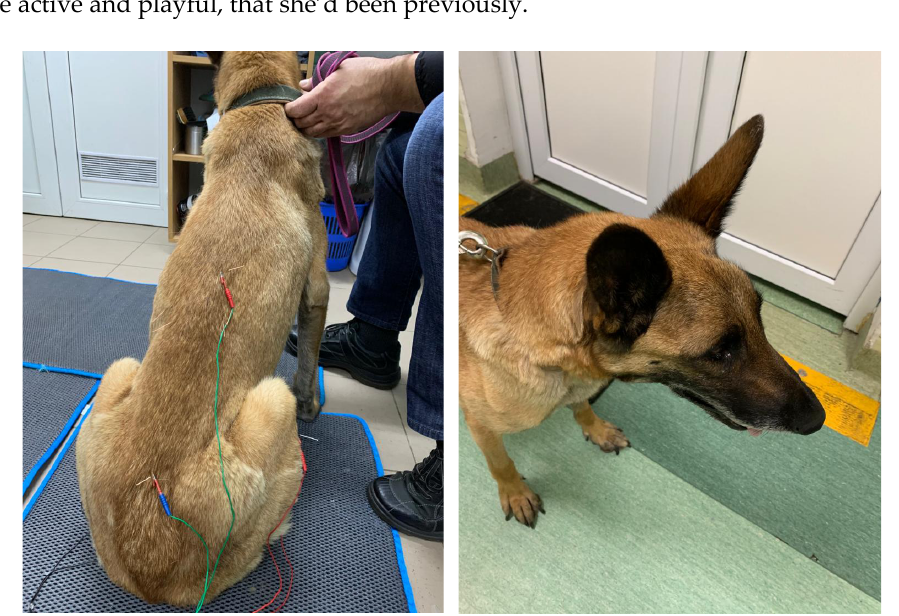
Fig. 5 . Aspects during electroacupuncture treatment. Fig. 6 . After 4 treatments. (Original